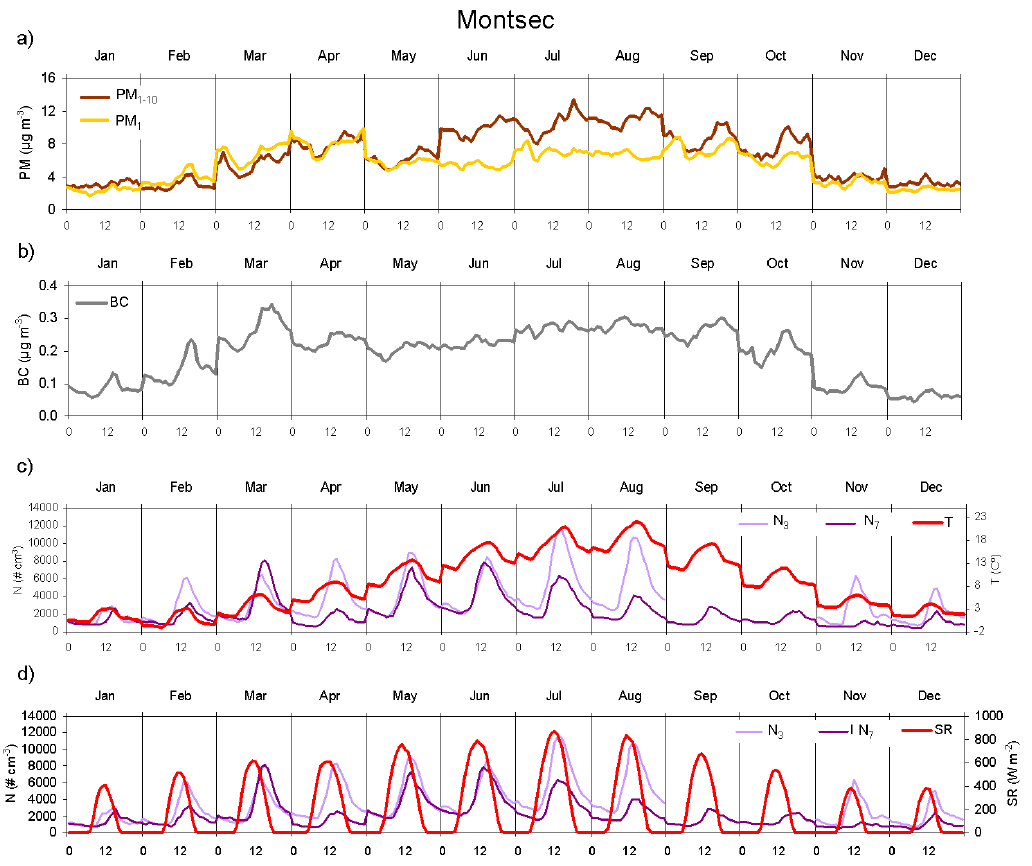
Fig. 12. Daily patterns of hourly (a) PM 1 , PM 1 − 10 , (b) BC, (c) N3, N7 and temperature, and (d) N3, N7 and solar radiation measurements averaged for each month during the study period at